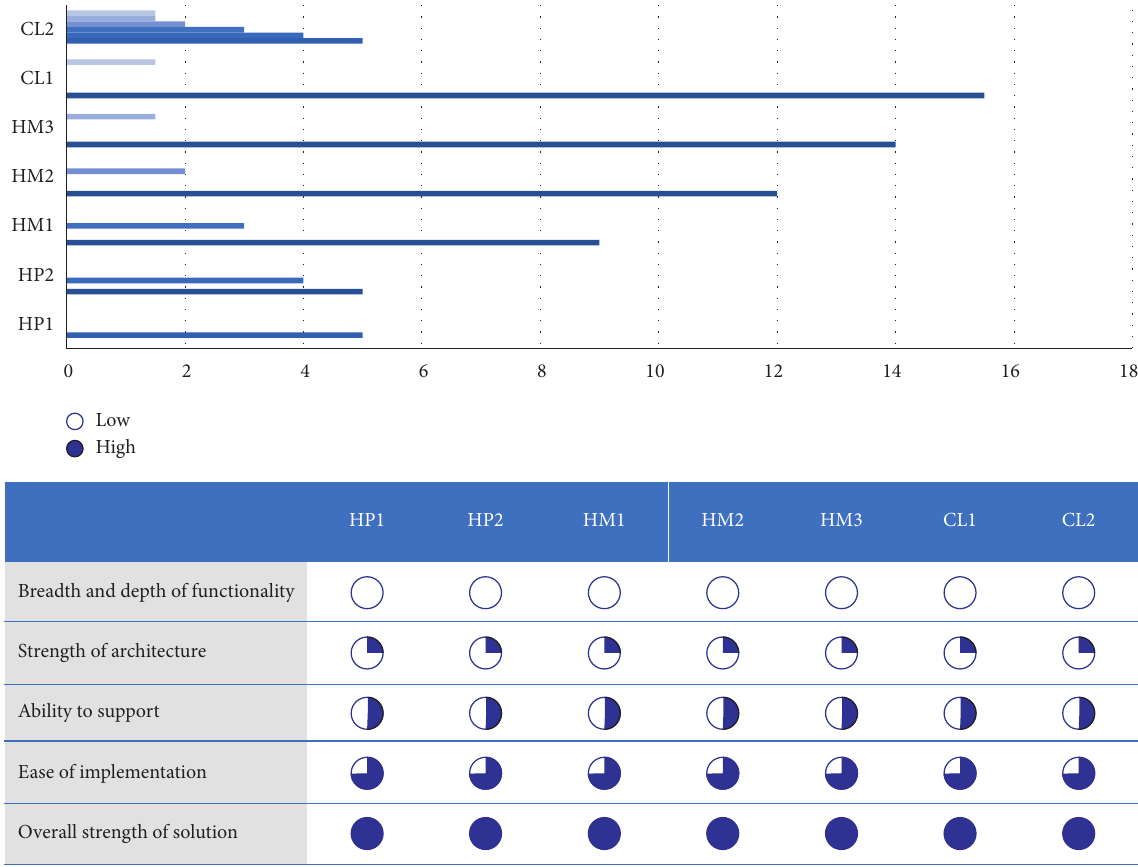
Figure 5: The learning behavior characteristic justification.